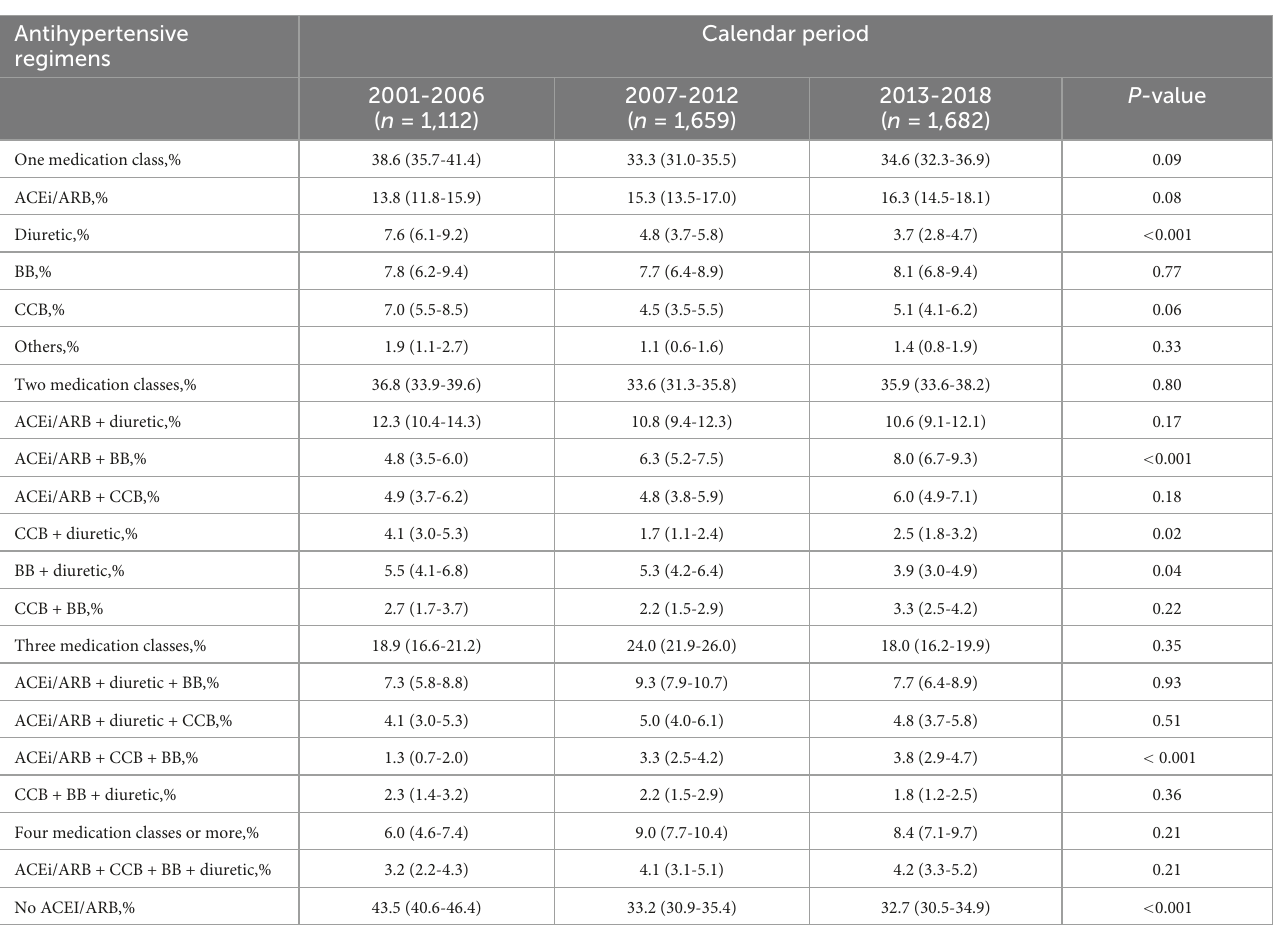
TABLE 2 Proportion of antihypertensive agent use among US adults with CKD in 2001-2006, 2007-2012, and 2013-2018. Antihypertensive regimens